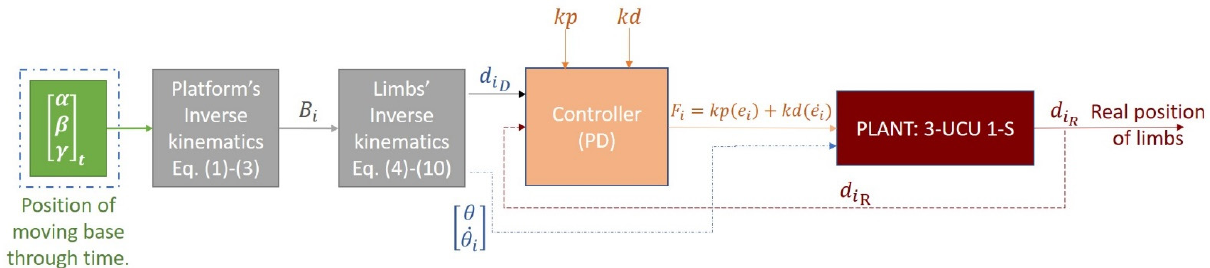
Figure 6. Block diagram for the implementation of the PD controller.